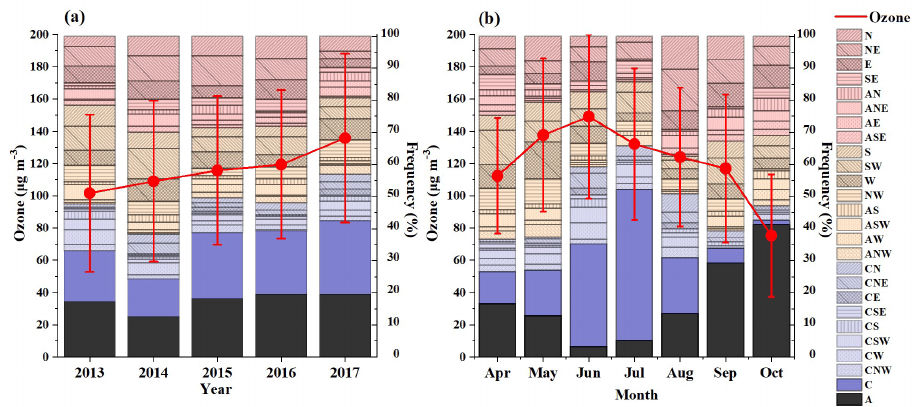
Figure 3. Interannual (a) and monthly (b) averaged concentrations of ozone and frequencies of 26 weather types from April to October 2013–2017. The red dots represent the mean values, the vertical red lines indicate the standard deviations, and stacked charts represent the percentages of various weather types (2013 and 2014 are averaged for 14 cities; 2015–2017 are averaged for 58 cities). The pink, orange, light blue, dark blue and black areas represent the weather categories N–E–S direction, S–W–N direction, LP, C and A,